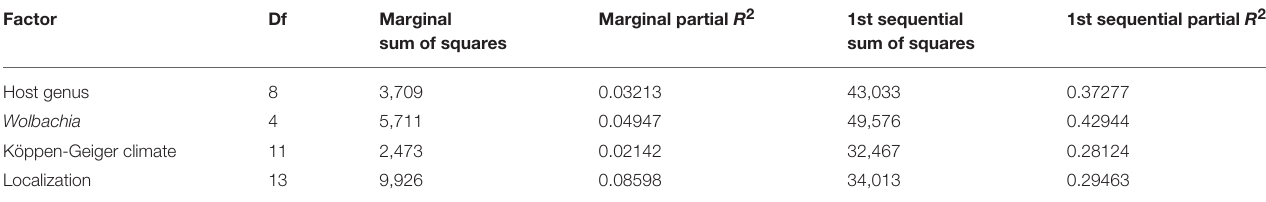
TABLE 4 | Sum of squares and partial R 2 of Host genus, Wolbachia infection status, Köppen-Geiger climate and localization taken either as marginal effect or as the first term when adding them sequentially.